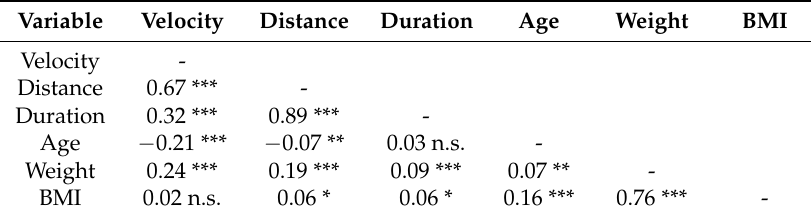
Table 3. Correlation coefficients between continuous outcome and predictor variables ( n = 1558). Variable Velocity Distance Duration Age Weight